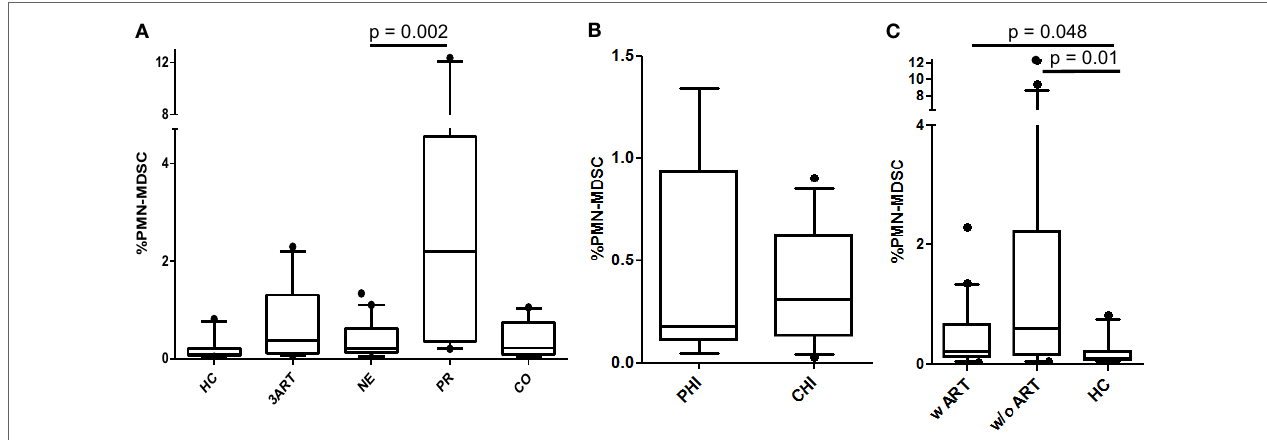
FigUre 1 | Frequencies of polymorphonuclear myeloid-derived suppressor cells (PMN-MDSCs). (a) New Era (NE) showed comparable frequencies to 3ART, but significantly lower frequencies than progressors (PR) ( p = 0.002). (B) Comparable frequencies in the subgroups primary HIV infection (PHI) and chronic HIV infection (CHI) ( p = 0.97). (c) The PMN-MDSC levels of patients with antiretroviral therapy (w ART) and w/o ART were significantly increased compared with the HIV- uninfected controls (HC) group ( p < 0.048) [HC: n = 10; 3ART: n = 10; NE: n = 19 (PHI: n = 8; CHI: n = 11); PR: n = 10; CO: n =